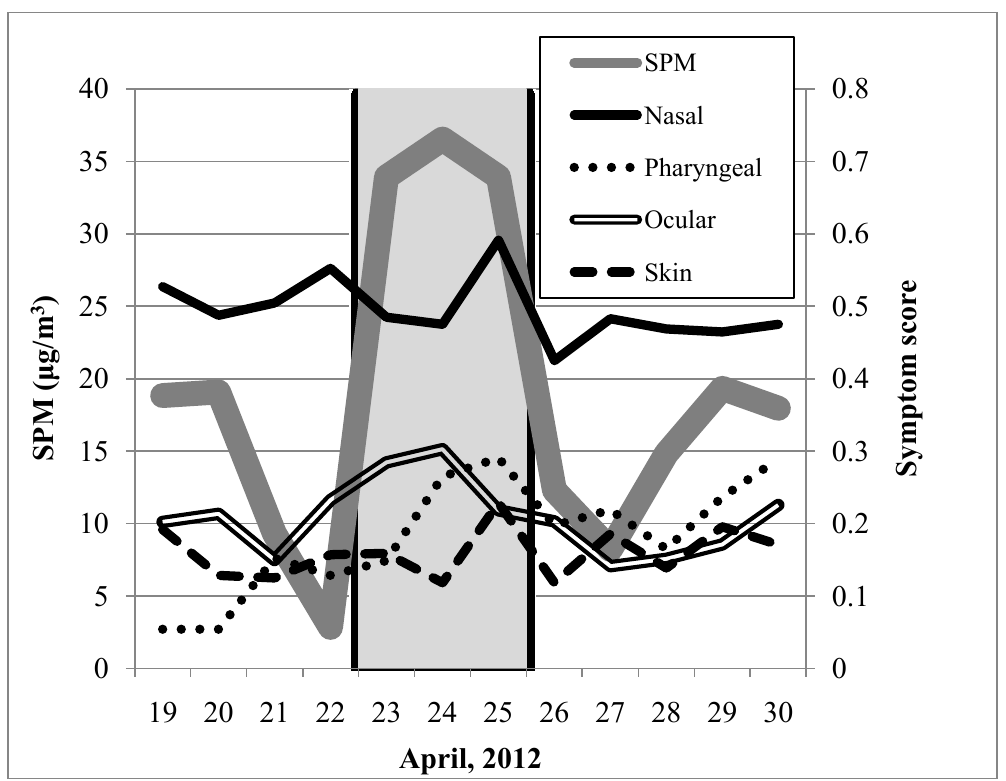
Figure 1. Time-course measurements of SPM levels and symptom scores from 19 to 30 April 2012. The gray zone indicates the Asian dust event.